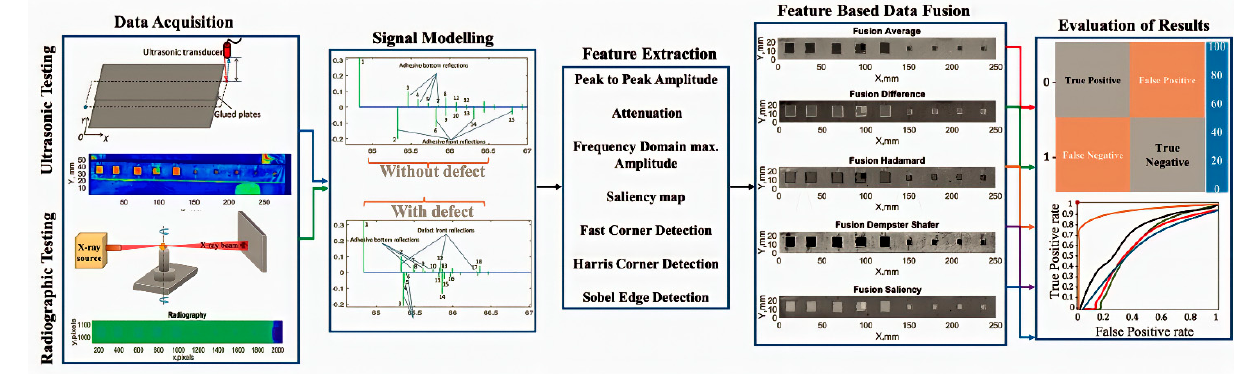
Figure 1. Schematic algorithm of the workflow.